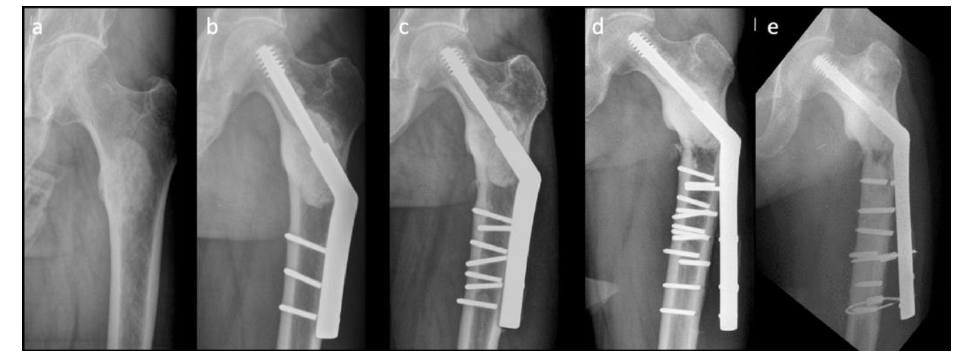
Figure 1. A difficult case with multiple implant failures: ( a ) preoperative X-ray image, ( b ) first-time implant failure, ( c ) second-time implant failure, ( d ) third-time implant failure, and ( e ) fourth-time implant